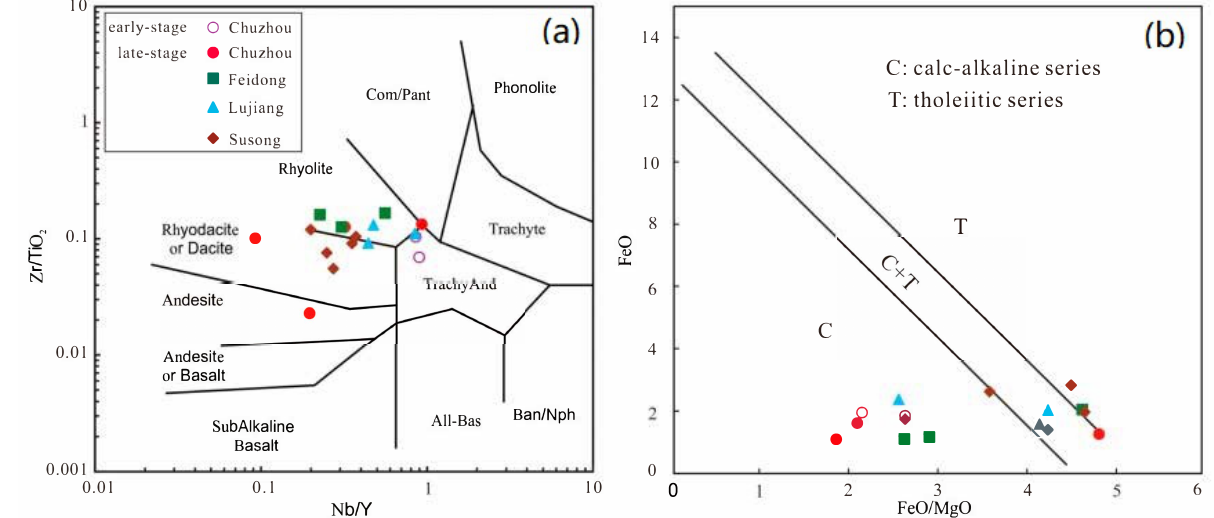
Figure 5. ( a ) Zr/TiO 2 versus Nb/Y diagram after [35] and ( b ) FeO versus FeO/MgO diagram after [36] for volcanic rocks of the Xileng Formation.